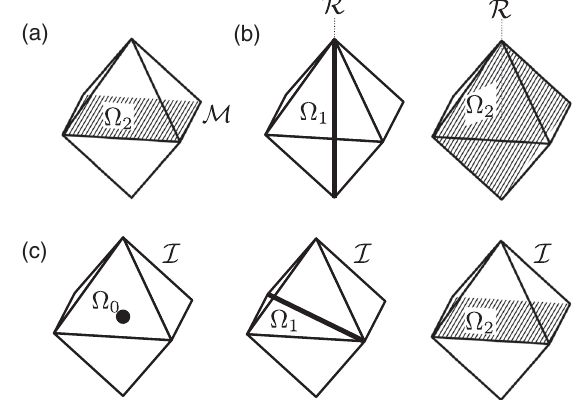
≤ k < d for three- with d − d k k is equal to the entire d